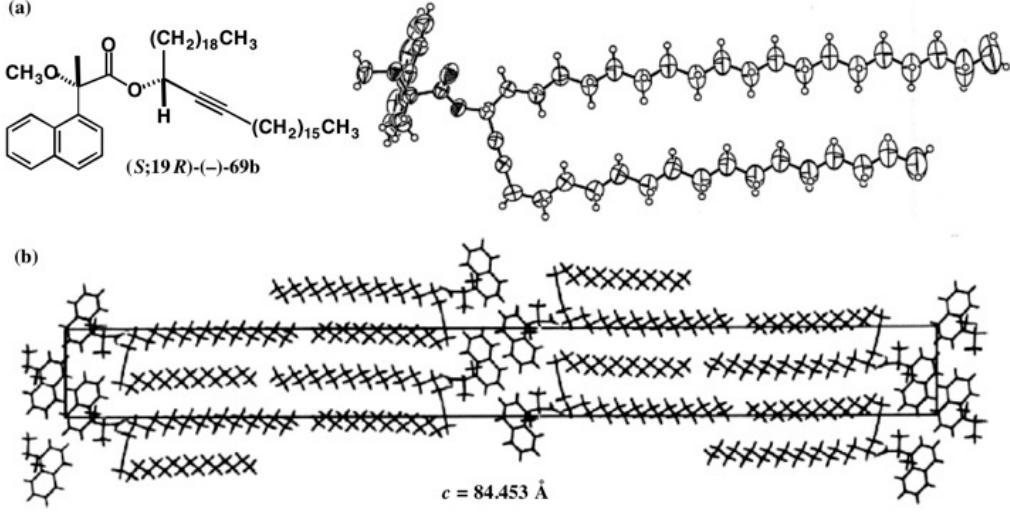
Figure 49. X-ray crystal structure of M α NP ester ( S ;19 R )-( − )- 69b . ( a ) ORTEP drawing; ( b ) Crystal packing of ( S ;19 R )-( − )- 69b : view along the a axis; the rectangle indicates a unit lattice. Reprinted with permission from [62].